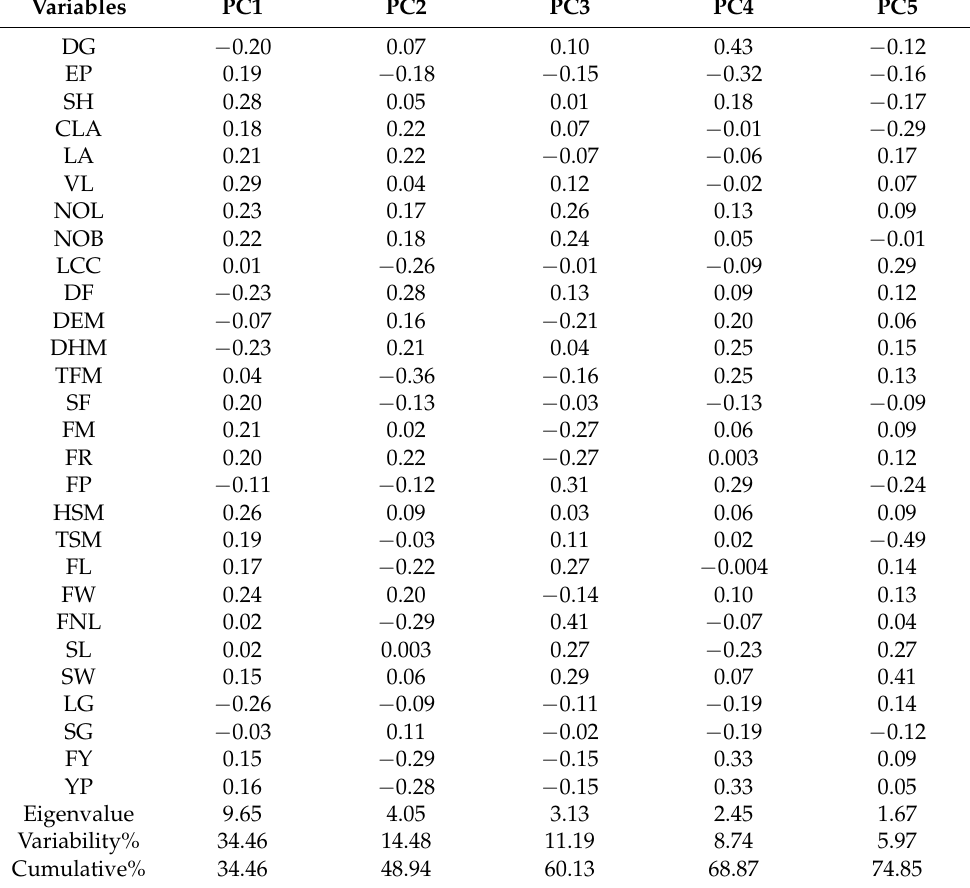
Table 6. Loadings of the variables for the first five principal